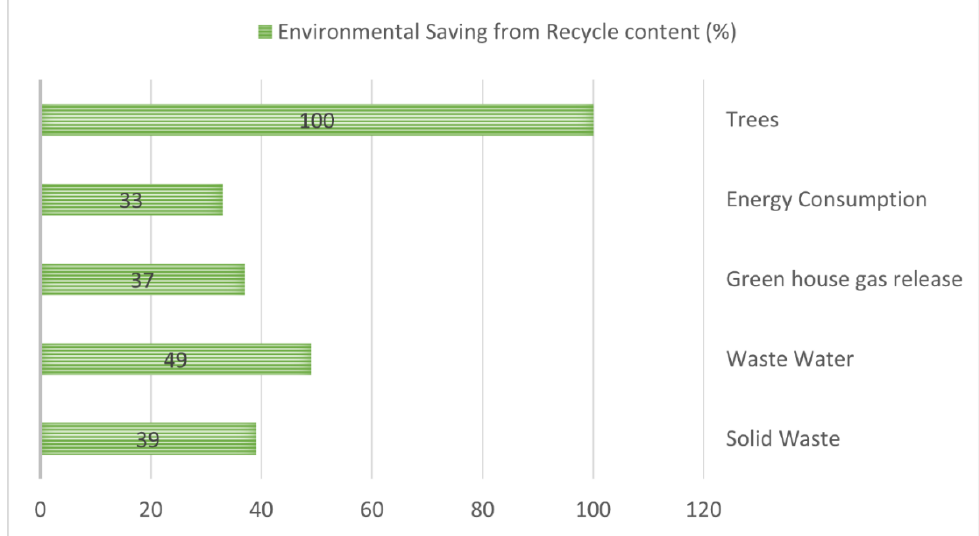
Figure 2. Environmental effect of virgin and recycled paper [47].